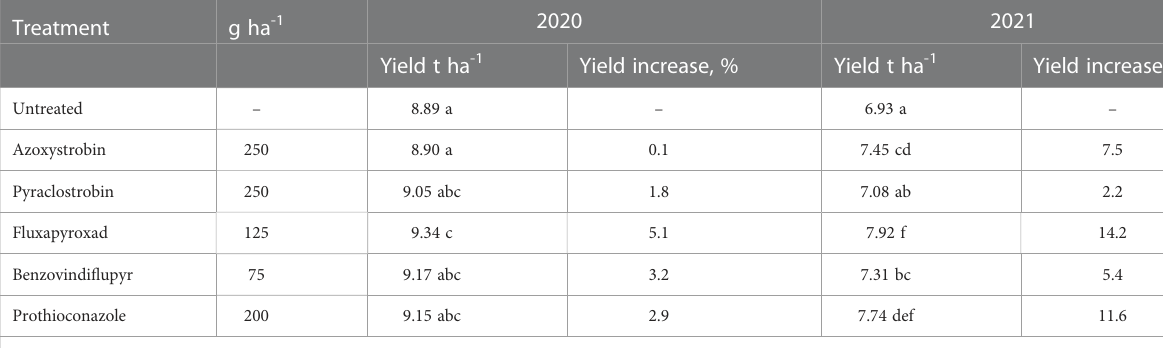
TABLE 6 Effect of fungicides on the grain yield of winter wheat in 2020 and 2021. Treatment g ha